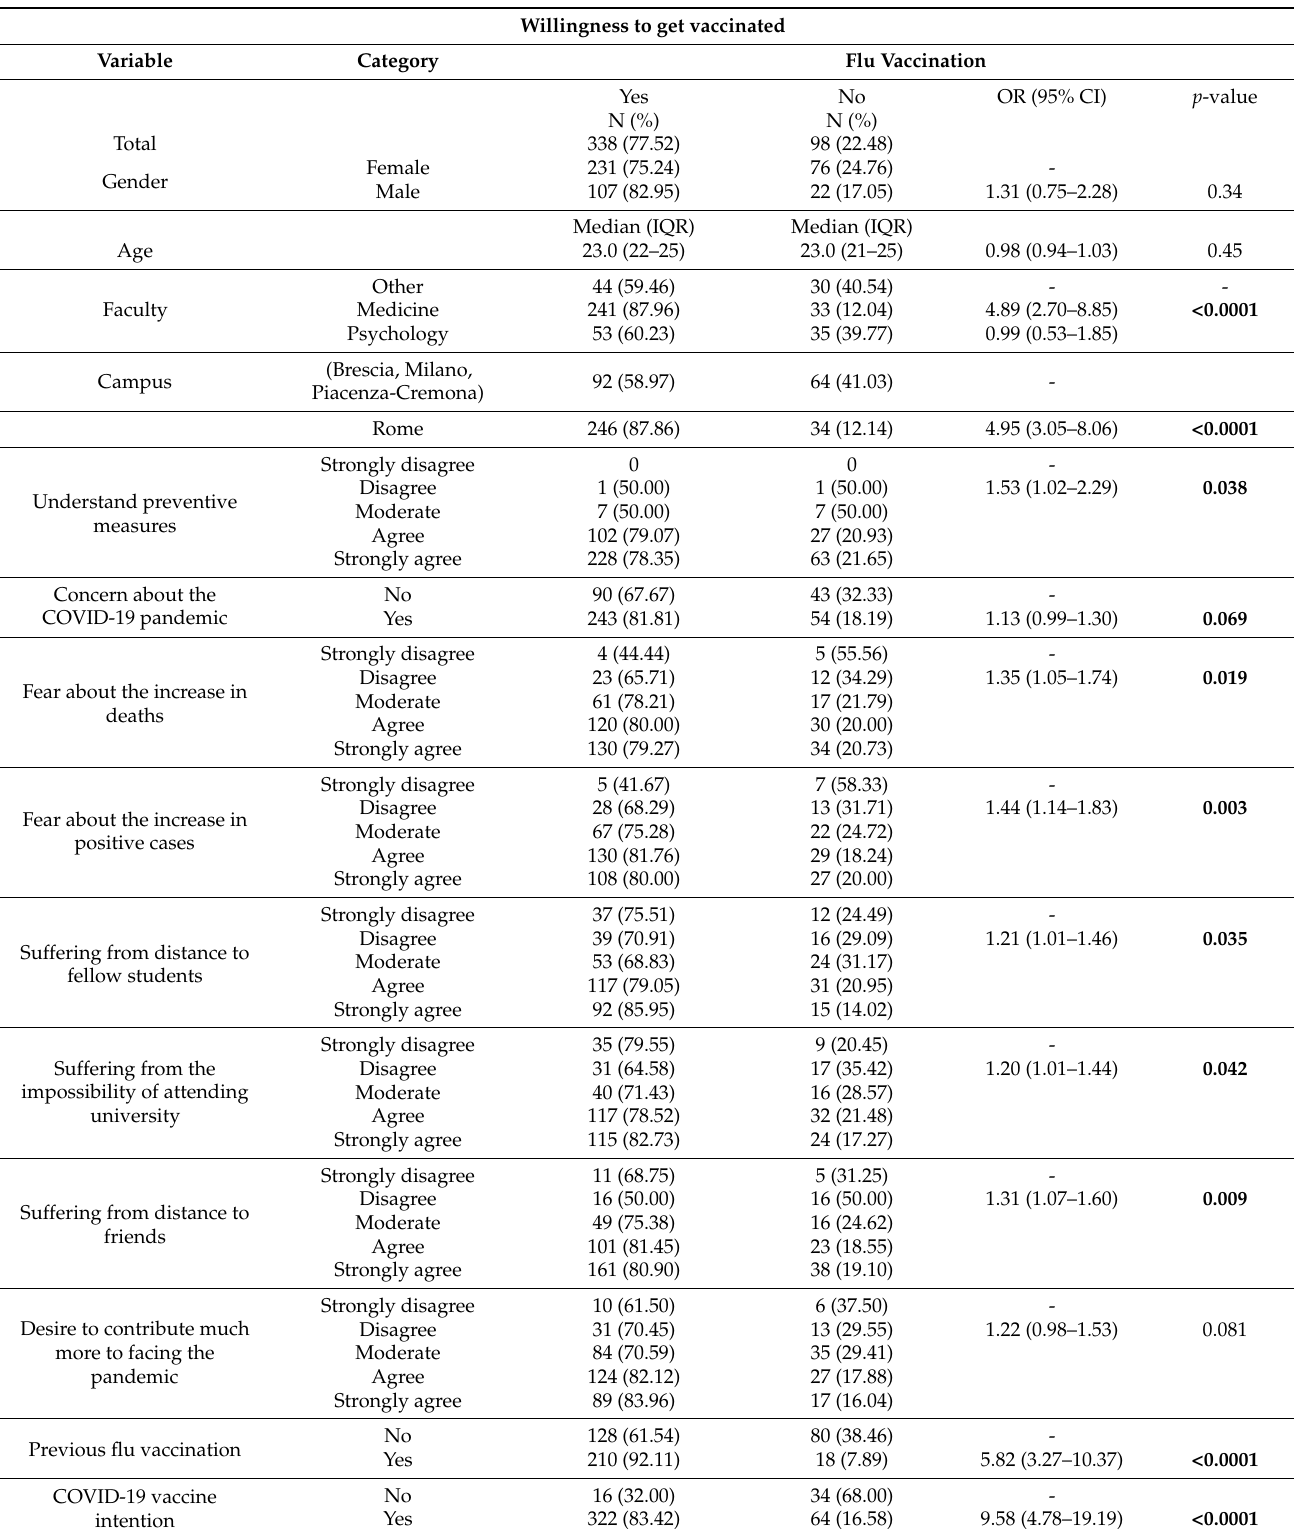
Table 1. Predictors of flu and COVID-19 vaccination (adjusted OR: odds ratio; CI: 95% confidence